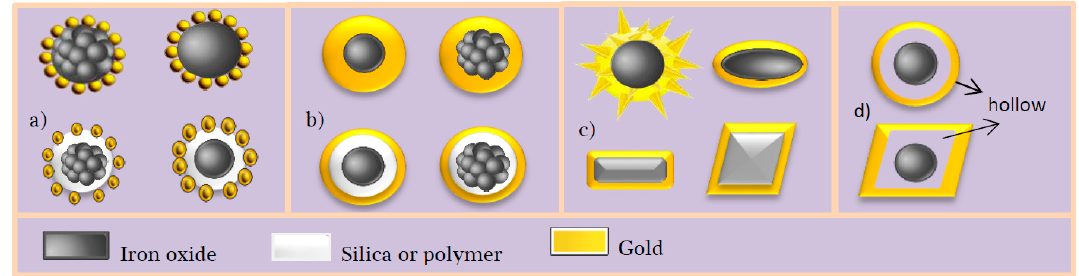
Figure 1. Main engineered structures of Fe 3 − x O 4 -Au Nanostructures (FANSs): ( a ) core-satellites; ( b ) spherical core-shell; ( c ) non-spherical core-shell and ( d ) hollow structures. Fe 3 − x O 4 -Au Core-Satellite Structure Fe 3 − x O 4 -Au core-satellite structure is defined as a particle with a single or multi Fe 3 − x O 4 cores